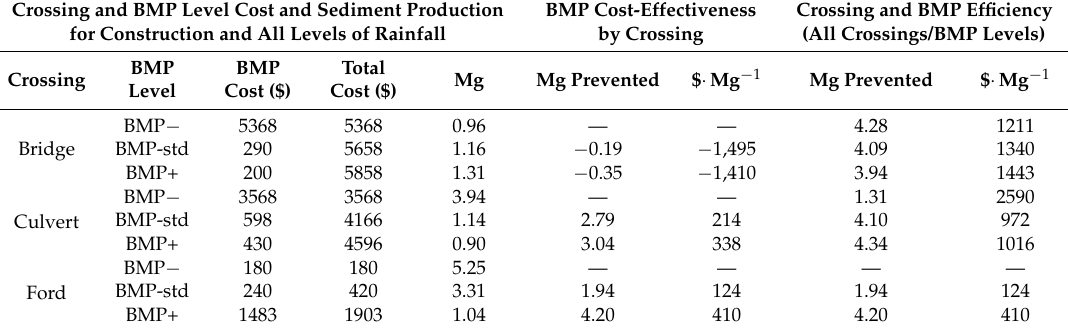
Table 7. Crossing and BMP costs and sediment production with associated cost-effectiveness ratio for sediment reduction (U.S. $ ¨ Mg ´ 1 of sediment